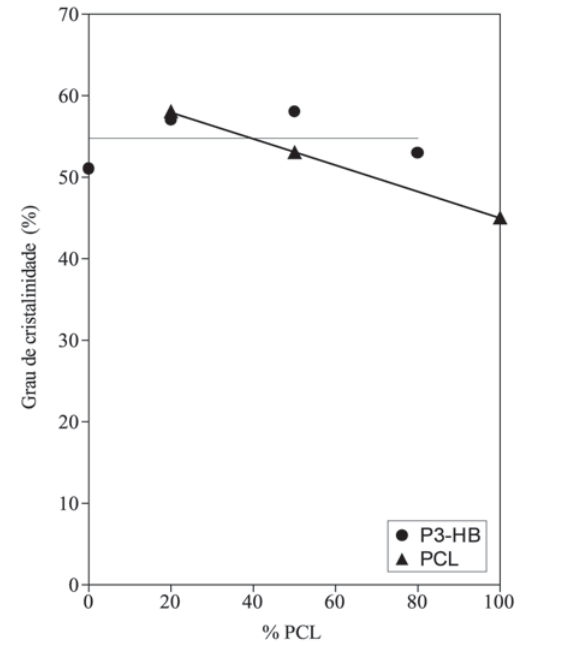
Figura 9. Grau de cristalinidade em função da % de PCL.